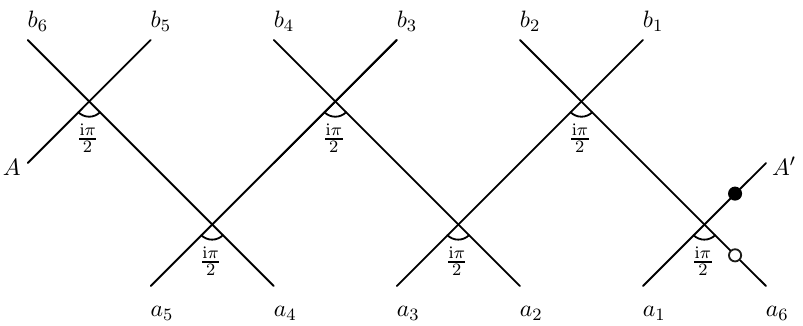
of the quasi-shift 2 L a 2 L (cid:0) 1 :::a 1